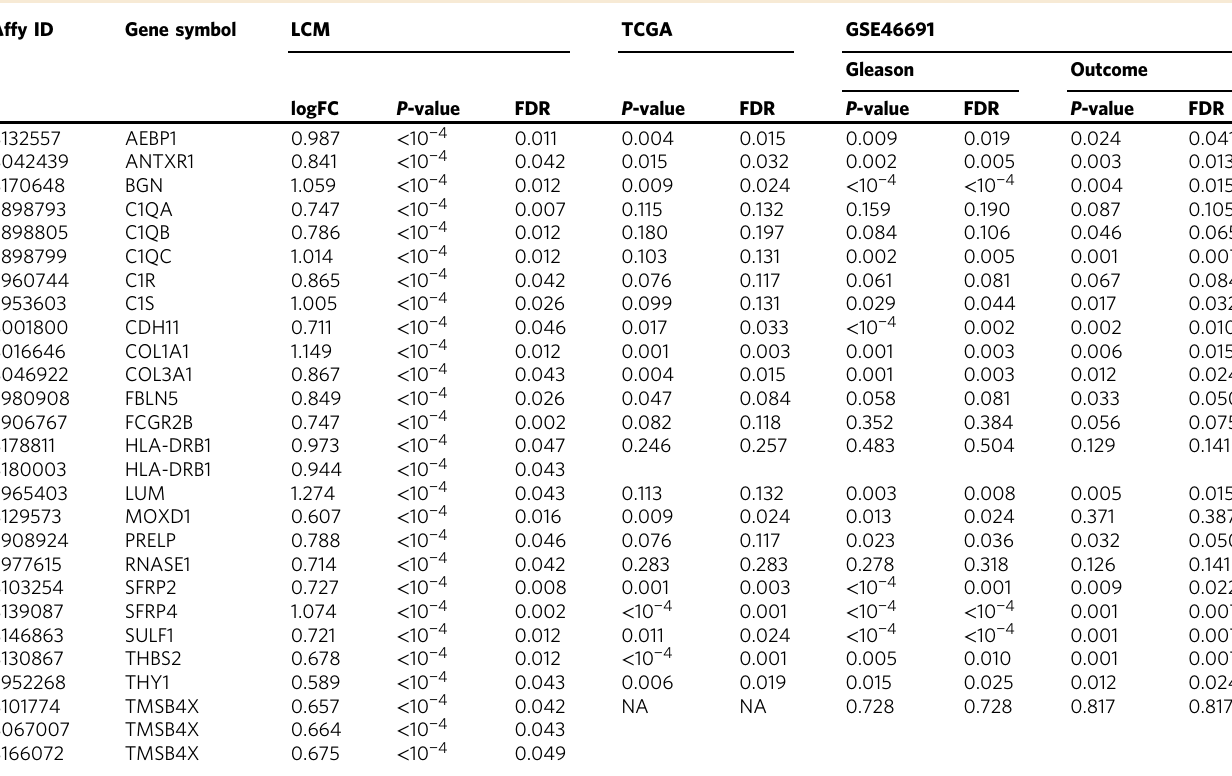
FDR false discovery rate, LCM laser capture